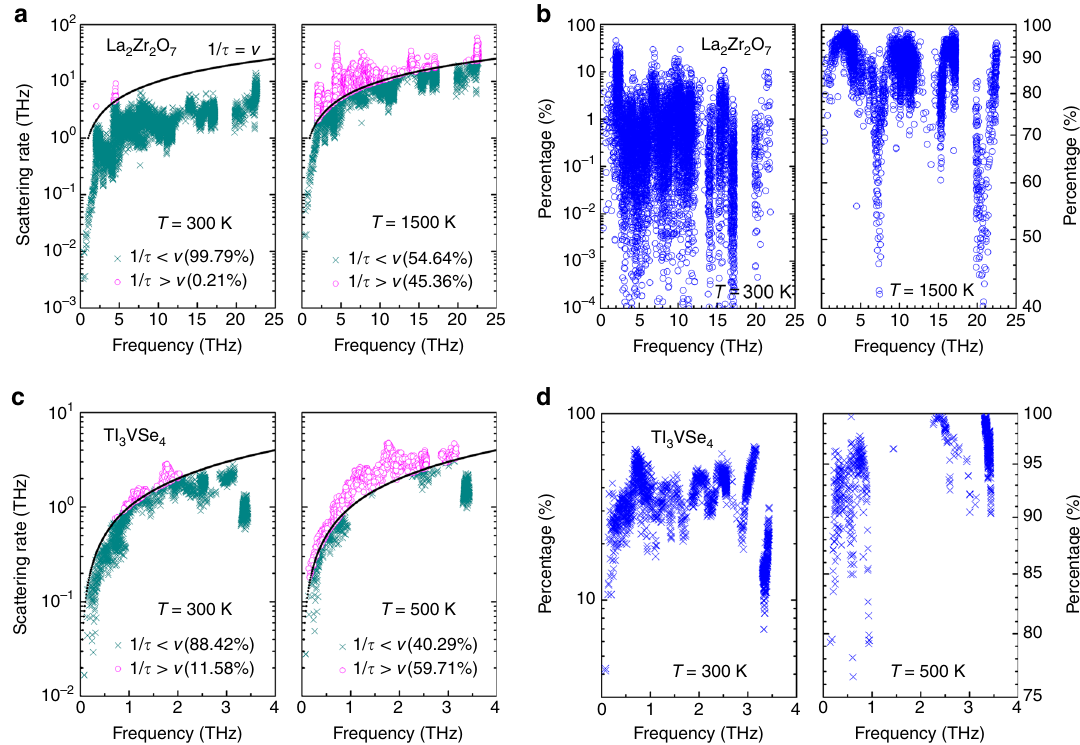
Fig. 5 Contributions from the ill-de fi ned-in-time phonons. a , c The scattering rates (1/ τ ) of La 2 Zr 2 O 7 and Tl 3 VSe 4 calculated from standard anharmonic lattice dynamics. The results at T = 300 K and T = 1500 K are presented for La 2 Zr 2 O 7 , and T = 300 K and T = 500 K for Tl 3 VSe 4 . The vibrational modes having 1/ τ < ν (well-de fi ned in the time scale) and 1/ τ > ν (ill-de fi ned in the time scale) are distinguished in different colors; and the baseline 1/ τ = ν is plotted as a guide for the eye. b , d The percentages of scattering rates of well-de fi ned-in-time modes contributed by three-phonon scattering processes involving at least one ill-de fi ned-in-time mode. Source data are provided as a Source data fi